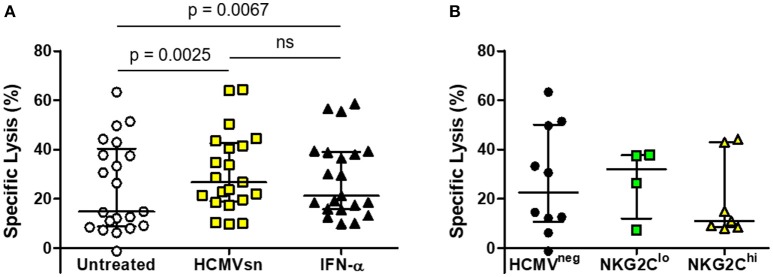
Effects of HCMVsn and IFN-α2 on ADCC of NK cells from HIV-infected individuals. (A) ADCC within the HIV-infected group was measured in 51Cr release assays over 5 h at E:T 30:1 in the presence of a 1:5 dilution of HCMVsn or 20 pg/mL recombinant human IFN-α2 as previously described and compared to untreated conditions (n = 21). (B) Baseline ADCC levels were compared between the three groups of HIV-infected individuals distinguished by HCMV serostatus and fraction of NK cells expressing NKG2C. Error bars represent median with IQR, performed in duplicate with conditions compared using Wilcoxon signed-rank test.